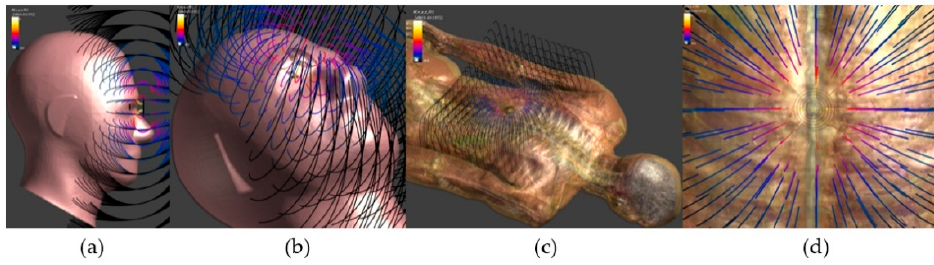
Figure 1. Examples of retinal prosthetics. ( a ) side view ( b ) whole view, spinal stimulation device ( c ) whole view ( d ) front view (simulated by Sim4life, human model software of IT’IS Foundation (Information Technologies in Society)).